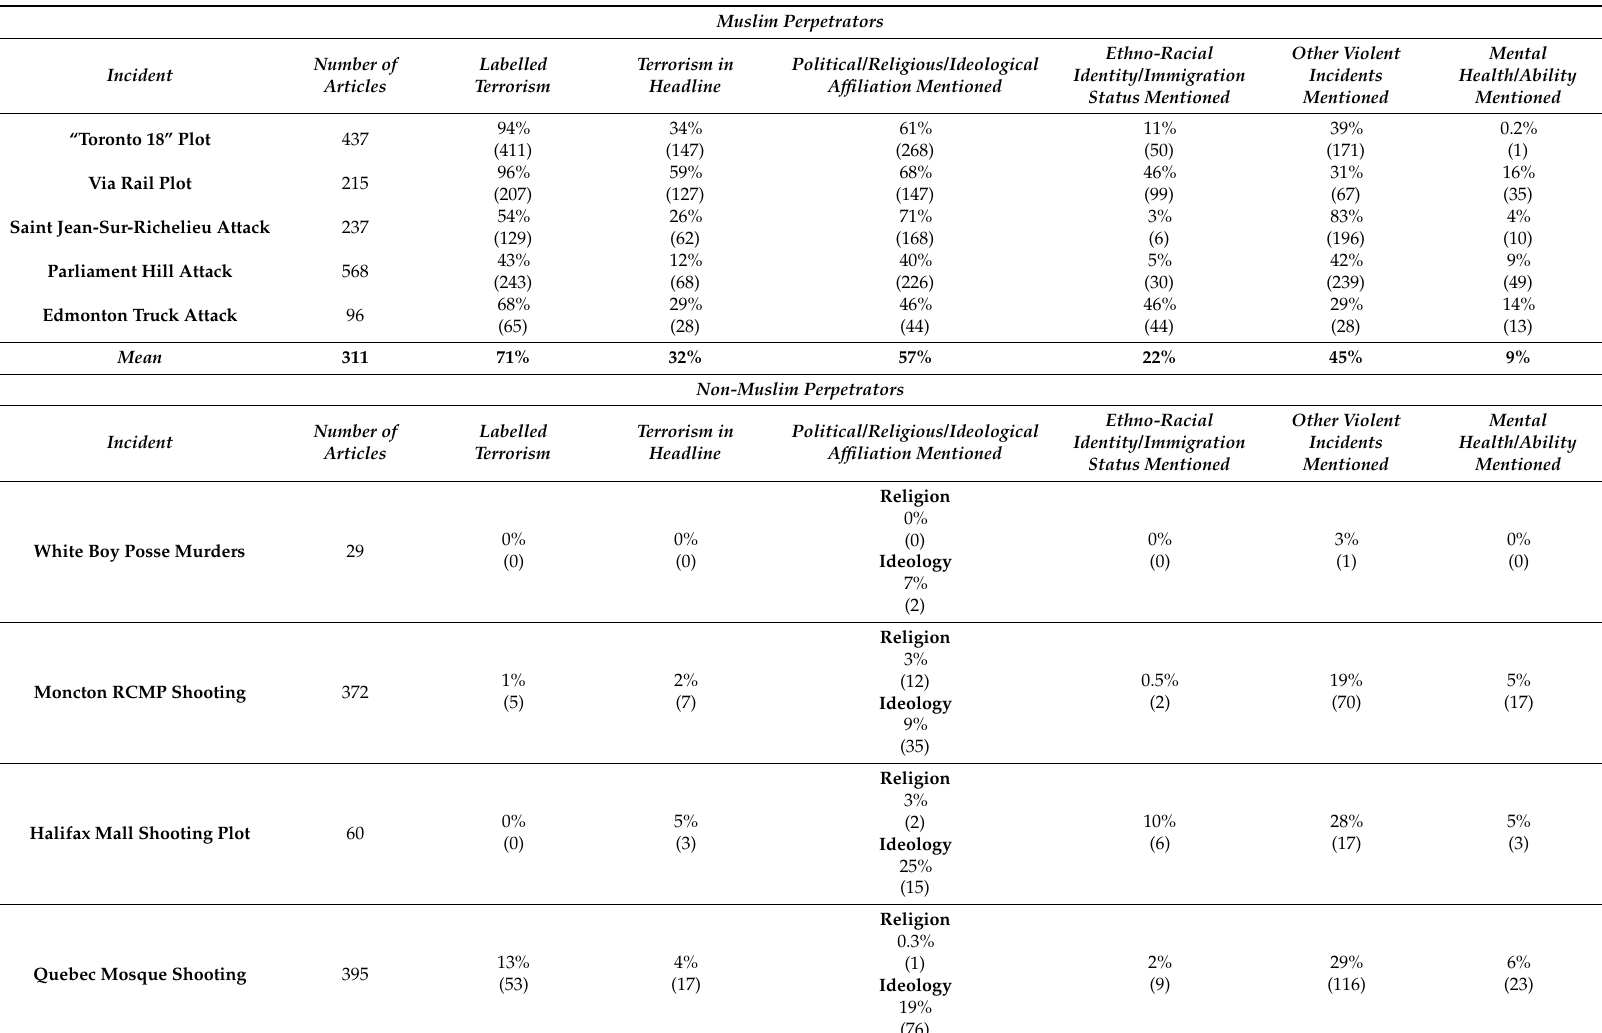
Table 2. Coverage of Incidents in National News